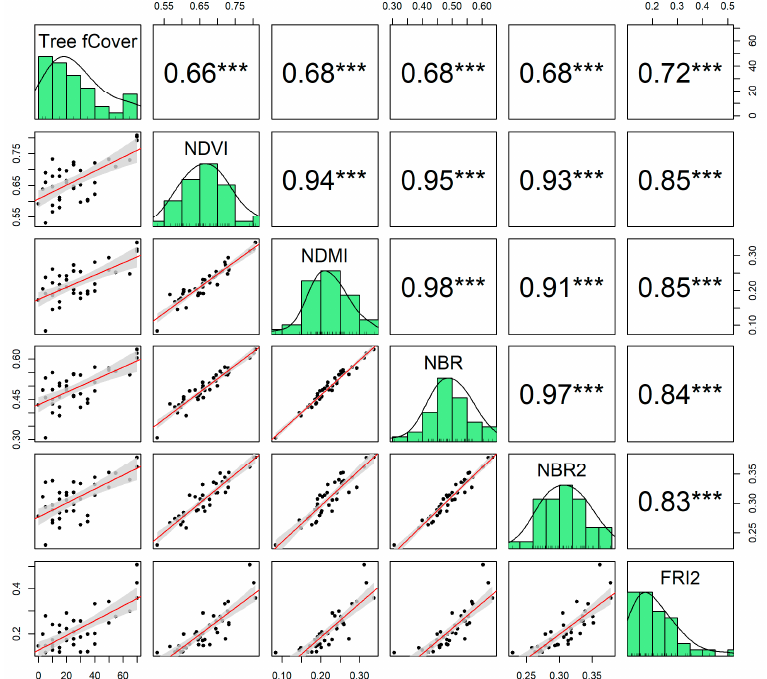
Figure 2. Correlation matrix of Pearson’s test between tree fractional canopy cover (Tree fCover) obtained from field data and Landsat spectral vegetation indices (SVIs). Asterisks indicate that all tests were significant ( p < 0.001).